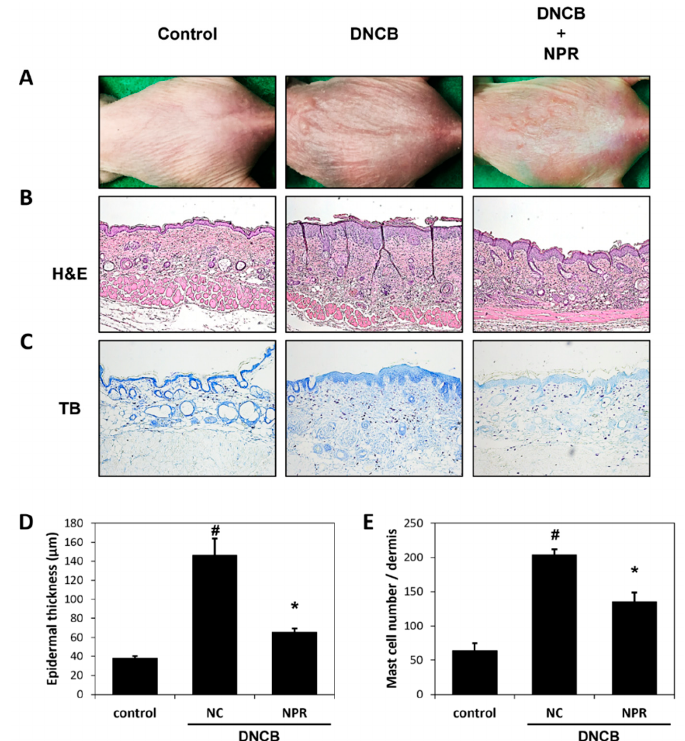
Figure 3. Histopathological changes by NPR extract. ( A ) AD clinical features of DNCB-induced mice, ( B , C ) H&E and toluidine blue staining, ( D ) epidermal thicknesses, and ( E ) mast cell numbers were measured in SKH-1 hairless mice after DNCB sensitization for 3 weeks. Results are expressed as the means ± SEs of 2 to 3 independent experiments. # p < 0.05 vs. untreated control group; * p < 0.05 vs. DNCB-treated mice. control: untreated control group; NC: DNCB-treated negative control group; NPR: DNCB plus N. peltata root extract-treated group.